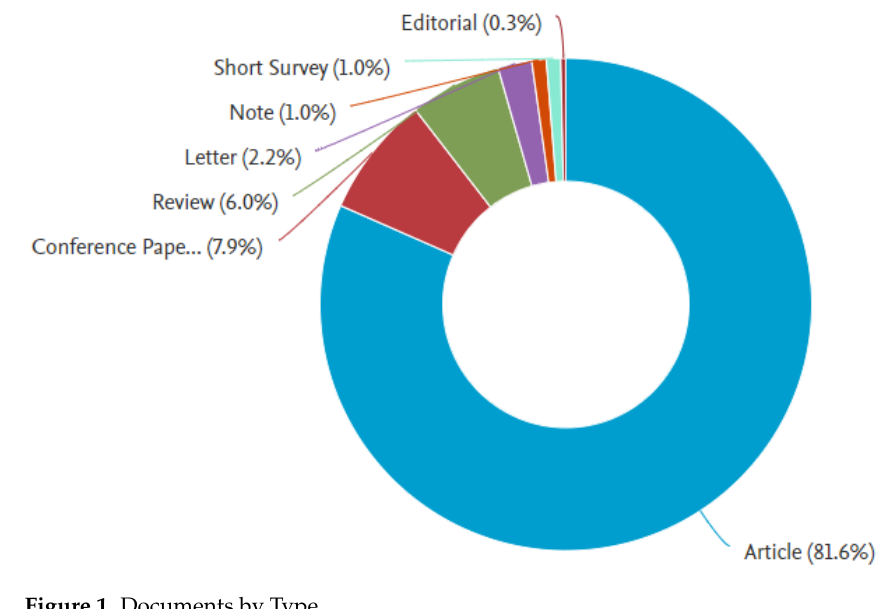
Figure 1. Documents by Type.